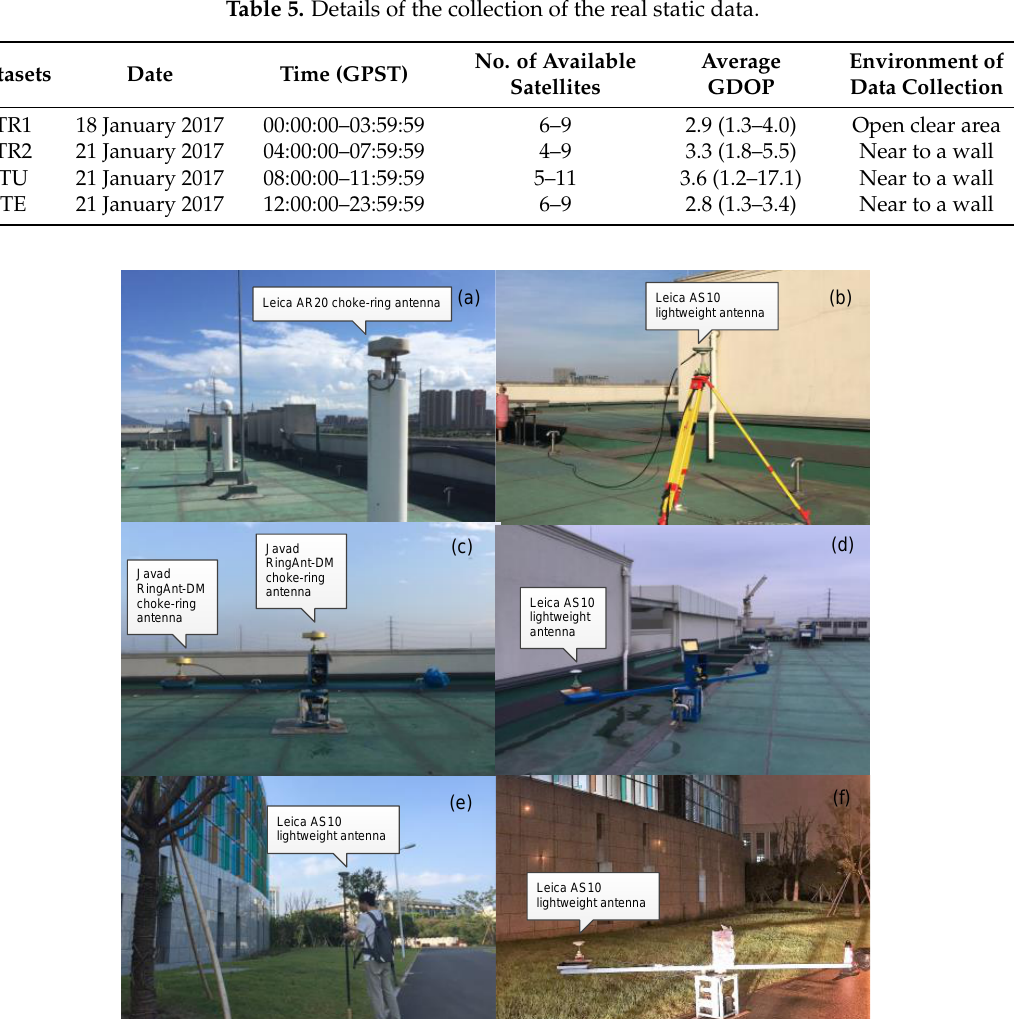
Figure 6. Images show the environments for the collection of ( a ) Dataset STR1; ( b ) Datasets STR2; STU, STE; ( c ) Dataset KTR1; ( d ) Datasets KTR2, KTU, KTE1; ( e ) Dataset KTE2; and ( f ) Dataset KTE3. Table 6. Details of the collection of the real kinematic datasets.